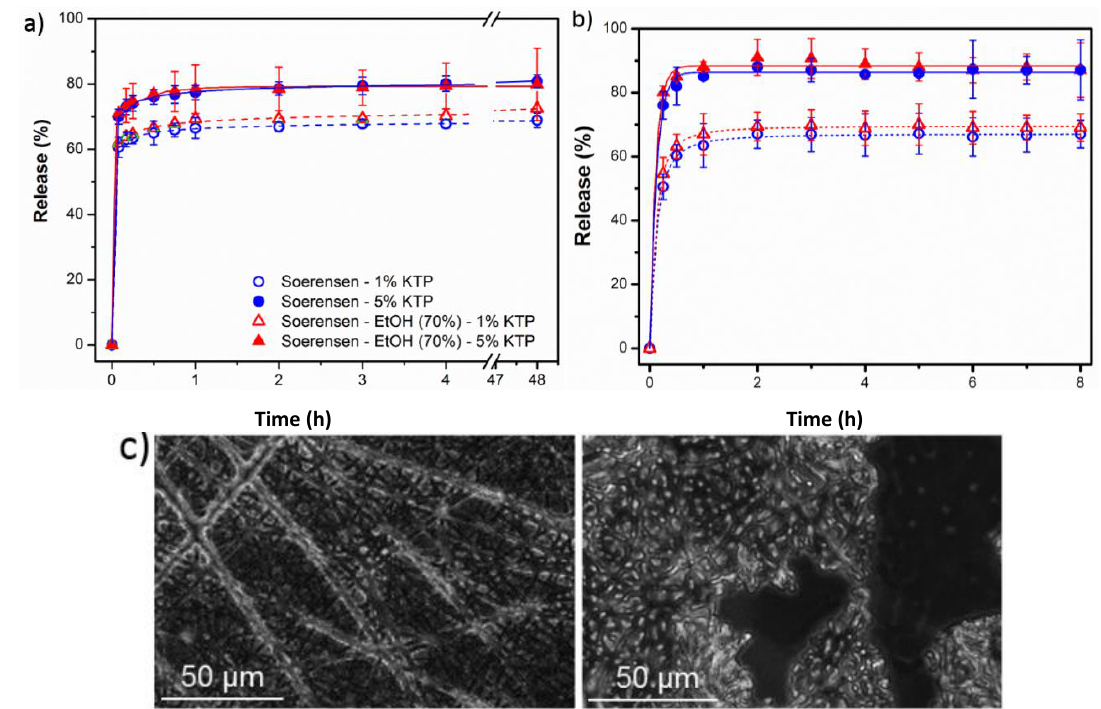
Figure 10. Ketoprofen release curves in Soerensen and Soerensen supplemented with ethanol 70% ( v / v) from poly(glc-5-glc 6) ( a ) and poly(glc-6-glc 6); ( b ) scaffolds loaded with 1% and 5% of the drug. ( c ) optical microscopy images of poly(glc-5-glc 6) scaffolds before (left) and after (right) the release